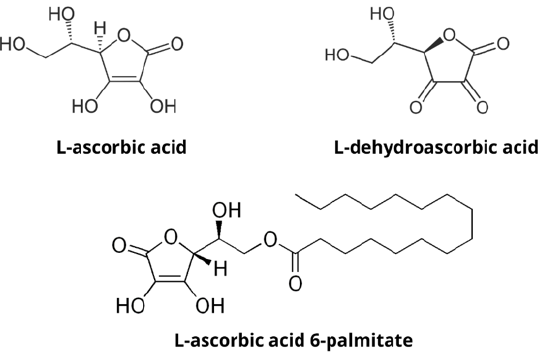
Figure 1. Chemical structures of hydrophilic compounds ascorbic acid and dehydroascorbic acid and lipophilic derivative, ascorbyl palmitate.